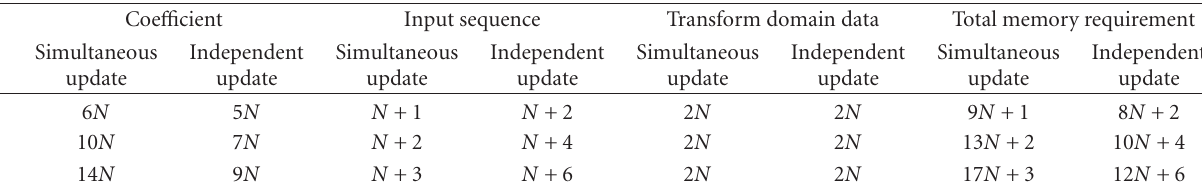
Table 3: Comparison of memory